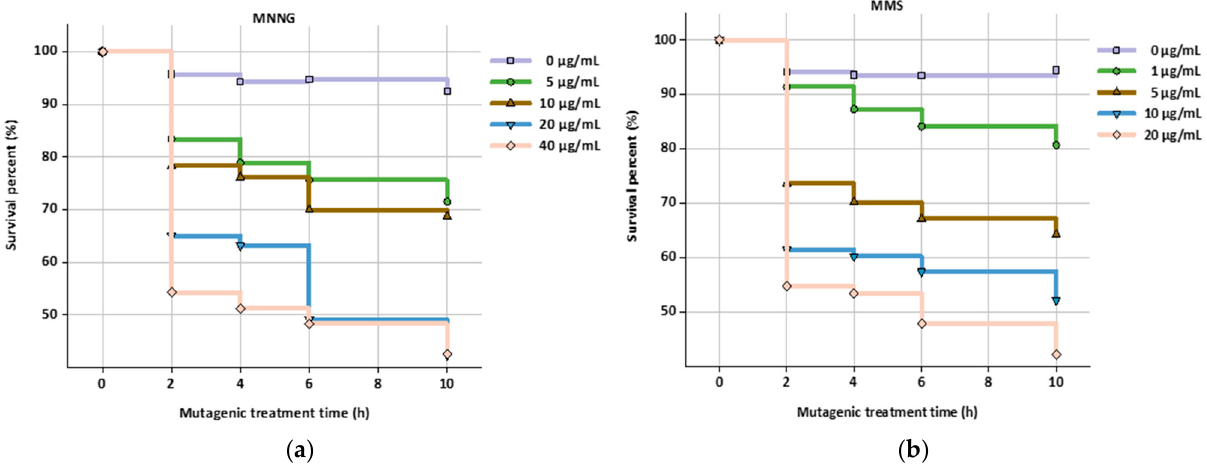
Figure 2. Effects of mutagen concentration and mutagenic treatment time on survival percentage (%) of the hybridoma cell line. ( a ) AFB 1 hybridoma cell line E 4 ; ( b ) OTA hybridoma cell line B 3 .